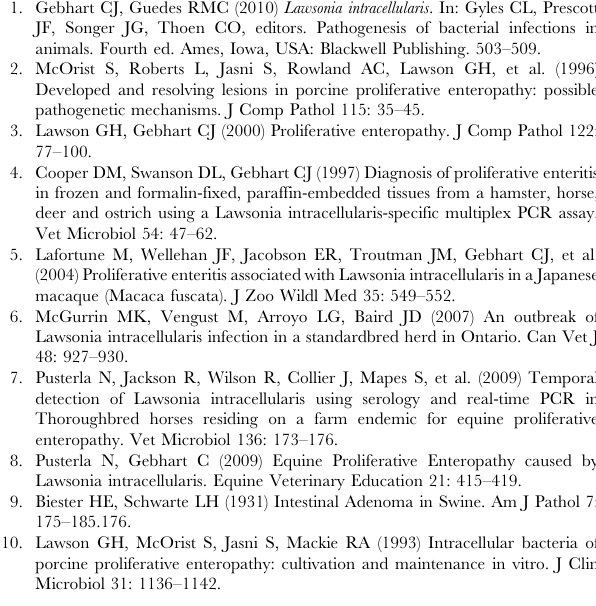
Figure S1 Reproducibility of biological replicates. RPKM of replicate 1 plotted on the y-axis and replicate 2 on the x-axis. Each spot represents a single gene. Black circles represent genes expressed by the pathogenic isolate (PHE/MN1- 00 at passage 10) and the linear regression (solid trendline 2 r 2 = 0.862). Gray squares represent genes expressed by the non- pathogenic isolate (PHE/MN1-00 at passage 60) and the linear regression (dashed trend line 2 r 2 =0.813). (TIF) Figure S2 RPKM representing the transcription levels (y-axis) and the number of mapped genes (x-axis) onto the L. intracellularis reference genome. (A) Pathogenic variant showing 720 expressed genes. (B) Non-pathogenic variant showing 330 expressed genes. The locus tags of the four highest expressed genes are described. (TIF) Table S1 Comparison between the transcription levels of genes commonly expressed by the pathogenic and non-pathogenic homologous L. intracellularis isolate PHE/MN1-00. (XLS) Table S2 Primers used for validation of RNA-seq expression data by quantitative reverse transcriptase PCR